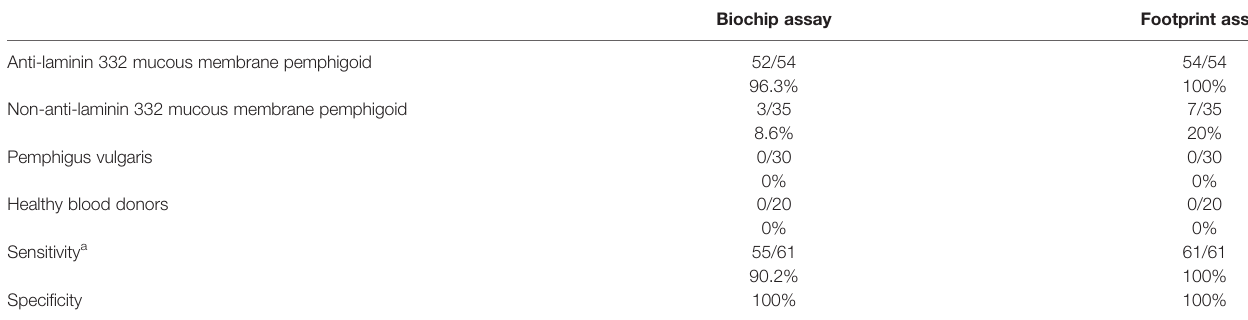
TABLE 2 | Comparison of anti-laminin 332 reactivity using the biochip and the footprint assay.